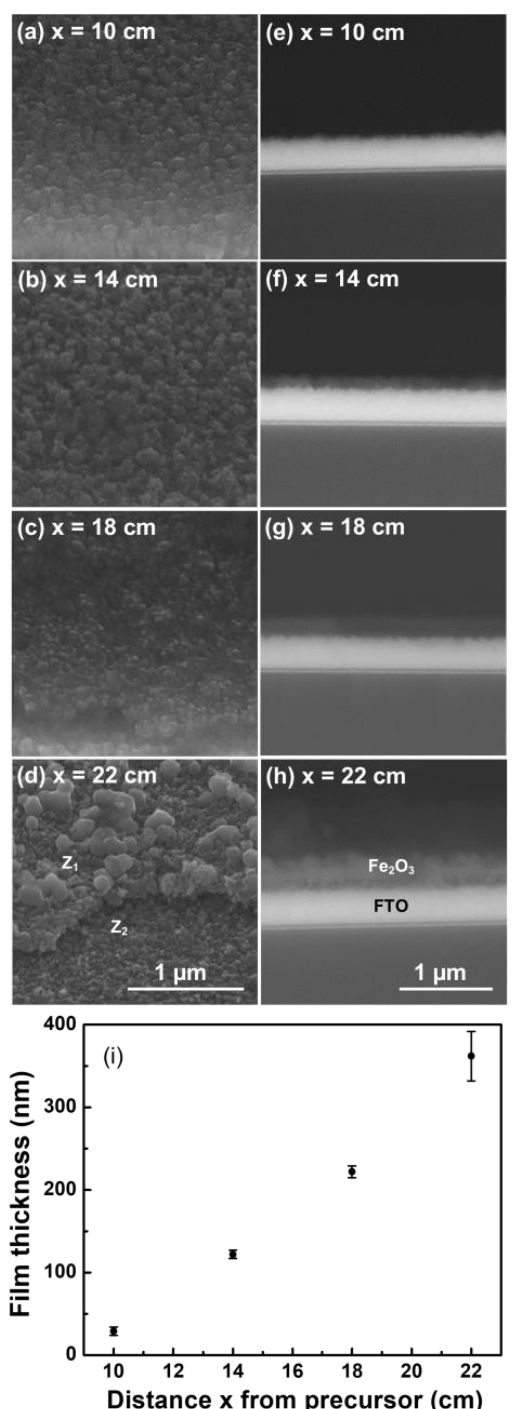
Figure 2. ( a – d ) correspond to 45-degree tilted view SEM micrographs of samples prepared at the positions 10, 14, 18, and 22 cm, respectively. In ( d ), Z 1 and Z 2 denote two different zones of the sample, the zone with hematite and the zone of bare FTO, respectively. ( e – h ) correspond to cross-section SEM micrographs of the same set of samples. ( i ) Plot of the film thickness (determined by the cross-section micrograph) as a function of their distance to the precursor.